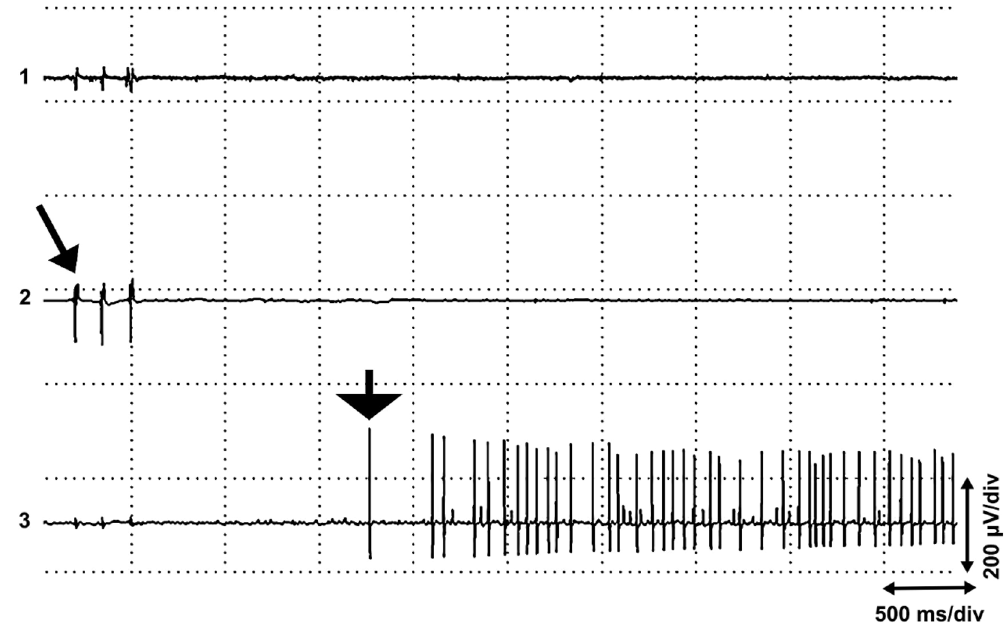
Figure 5. Activation of a sequence of end plate spikes. Passive stretching (slow extension of the forearm) of the muscle activates a sequence of local “end plate spikes” (channel 3, arrowhead). The last propagating motor unit potentials of the myotatic reflex are seen (tilted arrow), before the activation of end plate spikes in the biceps brachii